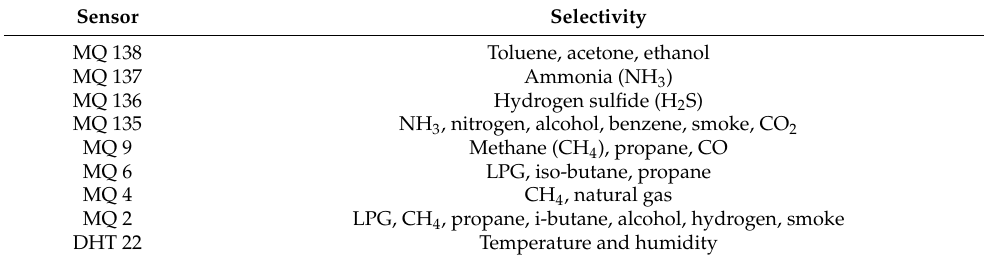
Table 1. Detailed description of the selectivity sensors in the sensor